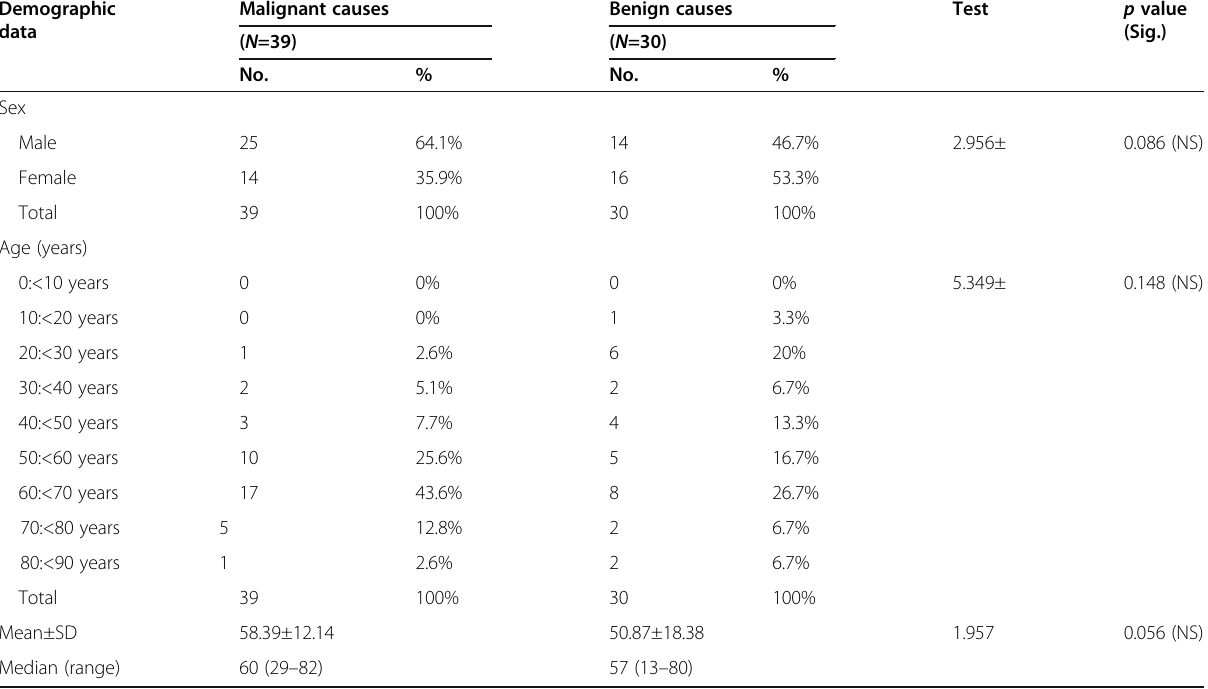
Table 2 Comparison between benign and malignant causes as regards demographic data Demographic data